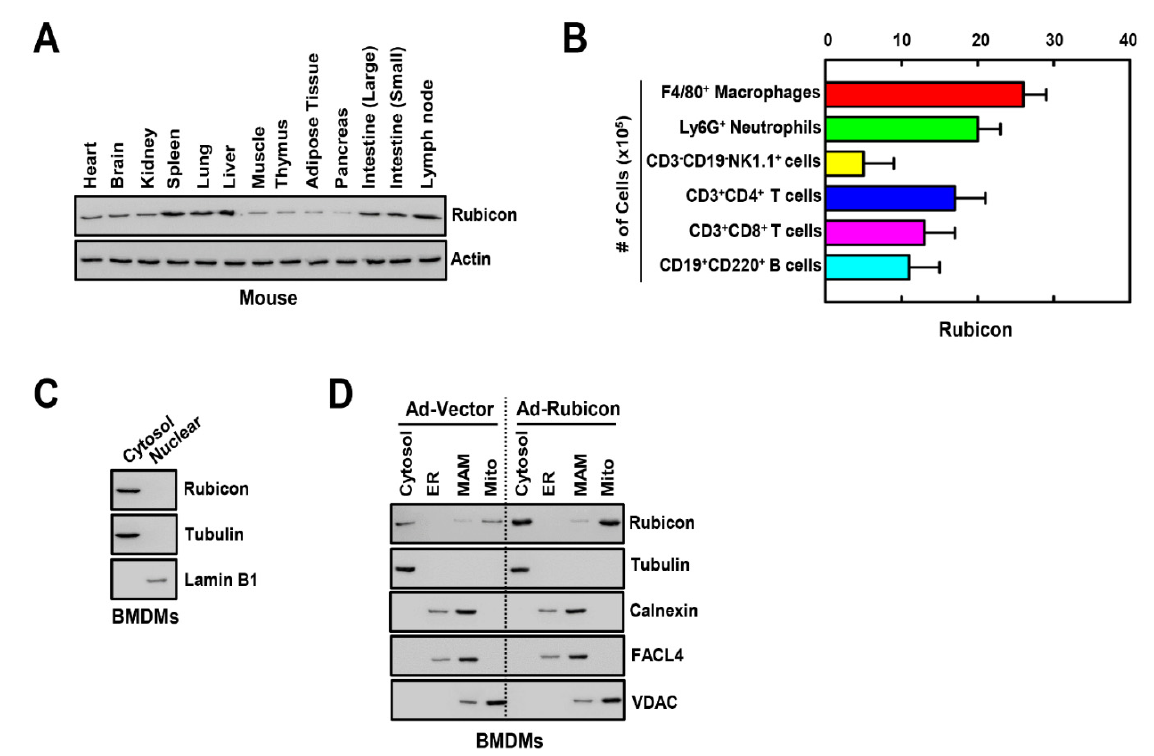
Figure 1. Tissue and subcellular distribution of Rubicon. ( A ) Each tissue was separated from mouse and homogenized. Rubicon expression was assessed by immunoblotting (IB) in various tissues from C57BL/6 normal mice. Whole-cell lysates (WCL) were used for the IB with α Actin. ( B ) Cell frequencies were determined with the 10-color flow cytometry panel and centralized manual gating on cryopreserved splenocytes samples. Differences in the frequency of major splenocytes subsets. ( C ) BMDMs were nuclear and cytoplasmic fractions separated and analyzed for Rubicon by IB. α Tubulin was detected as cytoplasmic protein loading controls. α Lamin B1 was detected as nuclear loading controls. ( D ) BMDMs from WT mice were transduced with Ad-Rubicon or Ad-Vector (MOI = 10) for 2 days. BMDMs were subcellularly fractionated and subjected to IB with α Rubicon. Levels of tubulin (cytosolic), calnexin (endoplasmic reticulum (ER) and mitochondria-associated membrane (MAM)), fatty acid CoA ligase 4 (FACL4, MAM) and voltage-dependent anion channels (VDAC, mitochondrial) protein in each fraction were determined by IB. Data shown are representative of three independent experiments with similar results ( A , C , D ). Data shown are the means ± SD of five experiments ( B